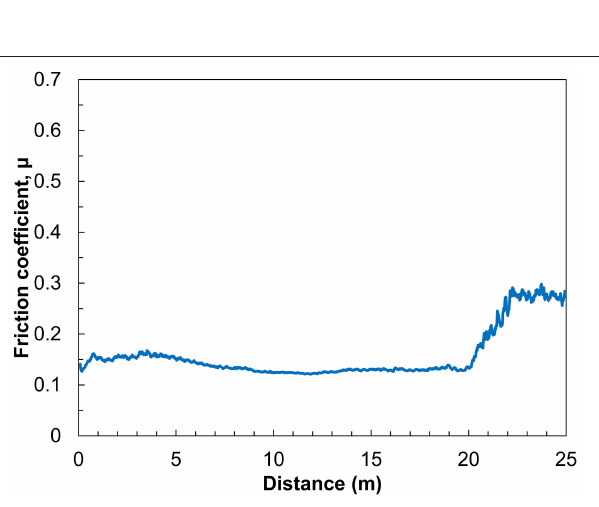
regime (calculations provided in the Supplementary Material